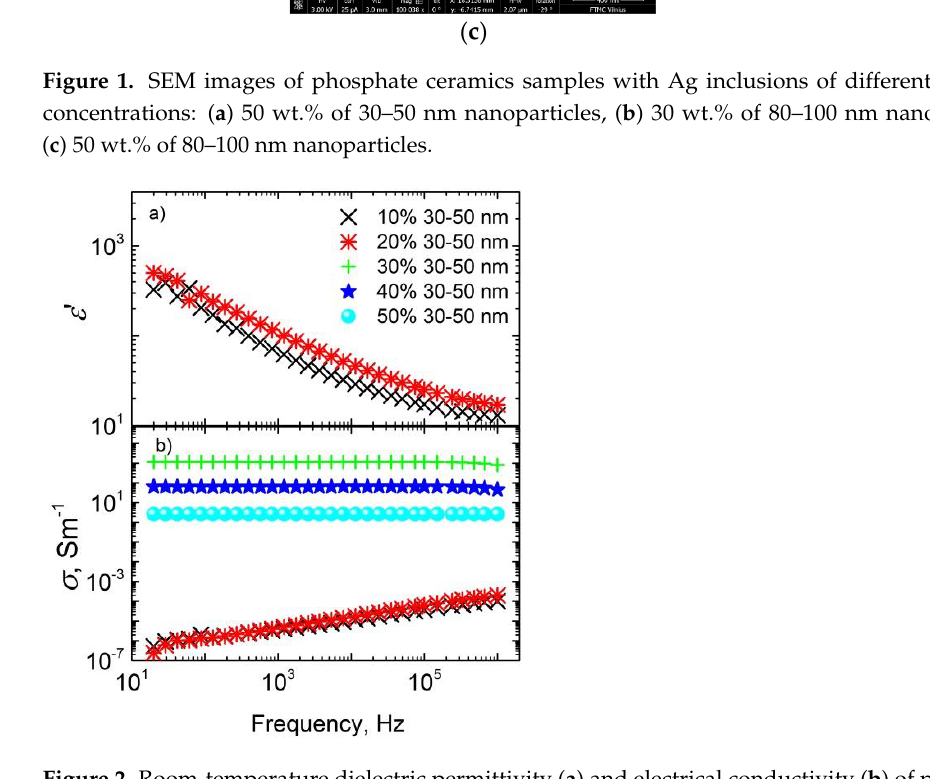
Figure 1. SEM images of phosphate ceramics samples with Ag inclusions of different size and con- centrations: ( a ) 50 wt.% of 30 – 50 nm nanoparticles, ( b ) 30 wt.% of 80 – 100 nm nanoparticles, ( c ) 50 wt.% of 80 – 100 nm nanoparticles.